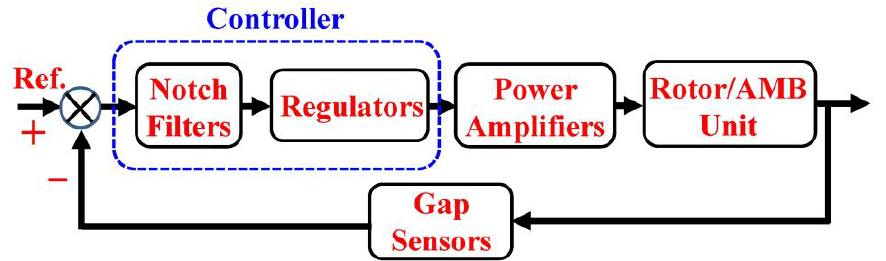
Figure 1. Control structure of rotor/AMB unit.